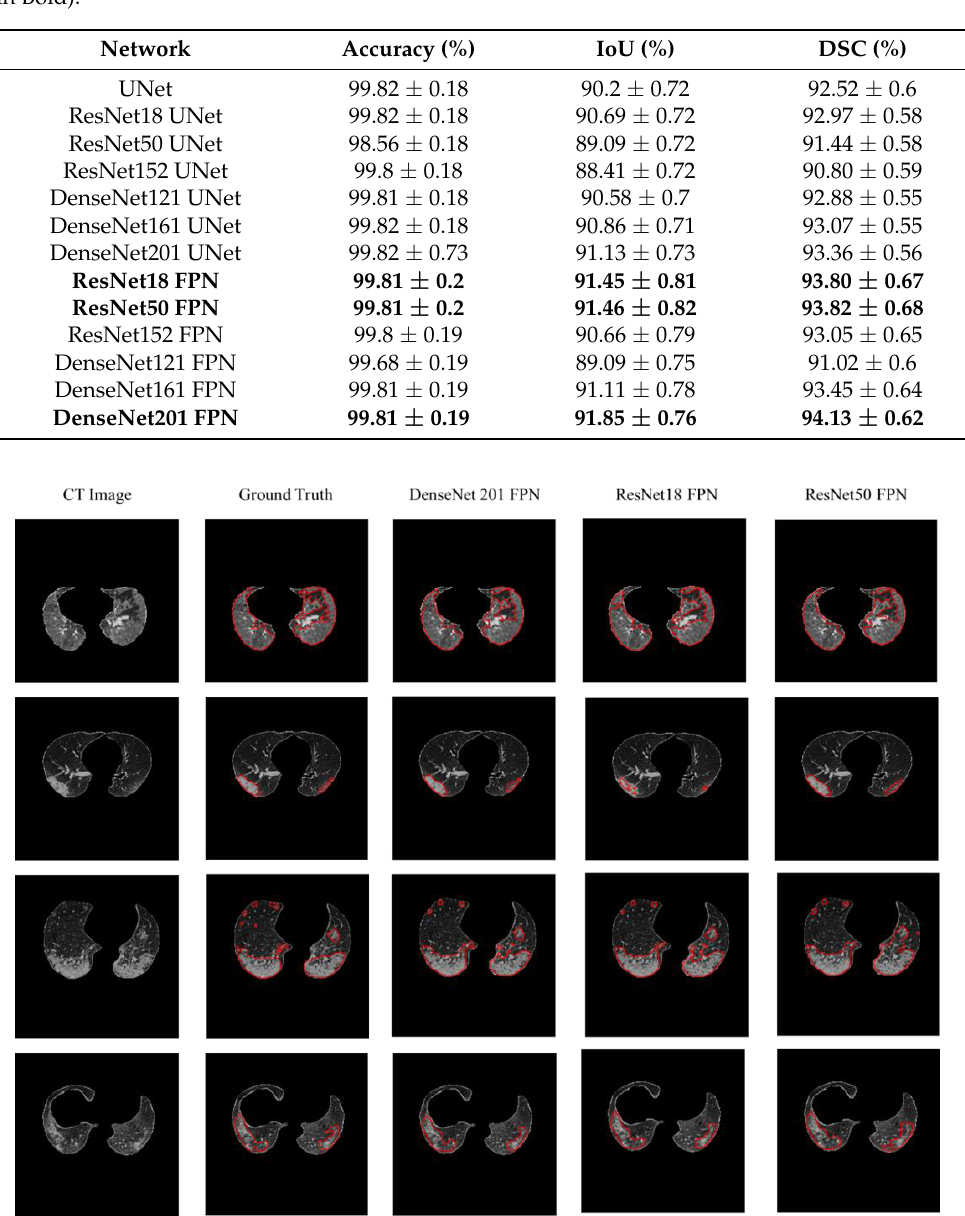
Figure 5. CT image (1st row), ground truth (2nd row), and the lesion segmentation of the top three networks (rows 3–5).